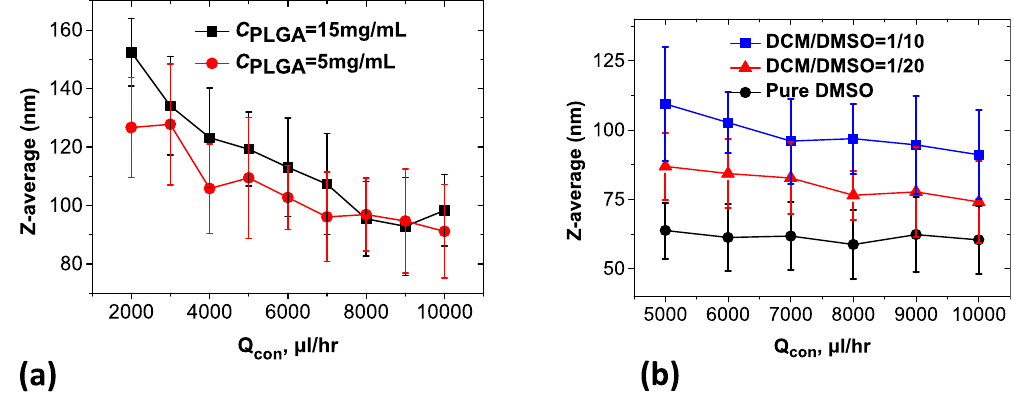
Figure 4. Hydrodynamic size of PLGA NPs synthesized with precursors of different flow ratios and different V DCM /V DMSO . Q dis = 50 µ L/h, Concentration of PLGA (Mw = 4000~15000 g/mol) = 5 mg/mL. Error bars are computed from the PDI width obtained by the 2 nd order Cumulant fit of the raw DLS